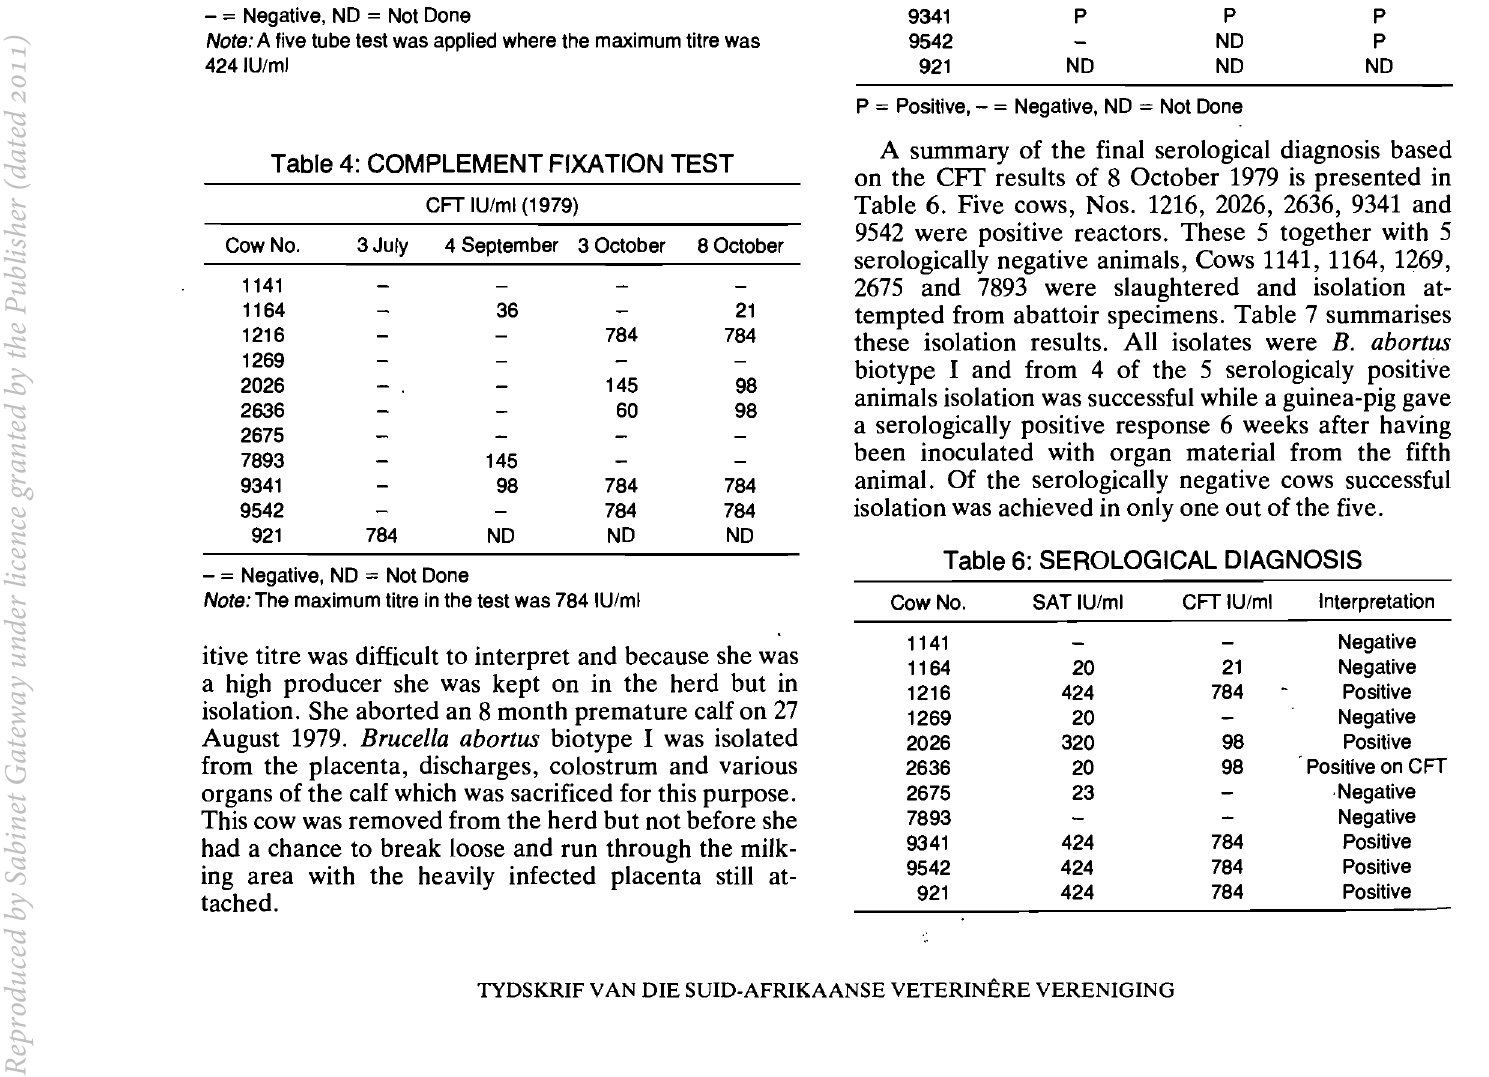
Table 5: MILK RING TEST